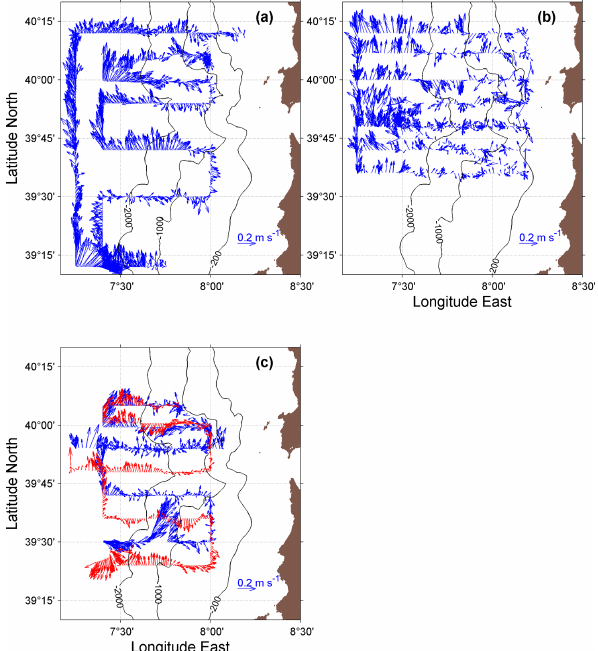
Figure 12. ADCP current vectors of Alliance (red) and Planet (blue) at 125m depth averaged over 300s for the time periods (a) 11 to 16 June, first CTD-chain tow; (b) 16 to 20 June, northern CTD- transects; and (c) 21 to 23 June, second CTD-chain/ScanFish tow, including the isobaths at 200, 1000, and 2000m depth.